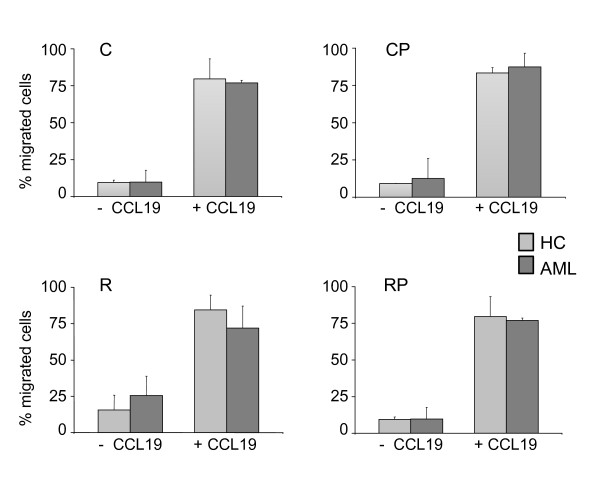
Migratory capacity of DCs to CCR7 ligand. Depicted are data of at least two independent trans-well migration assays using CCL19 (100 ng/mL) as chemoattractant for DCs generated with cocktail C, CP, R and RP. Shown are the mean values ± standard deviations.